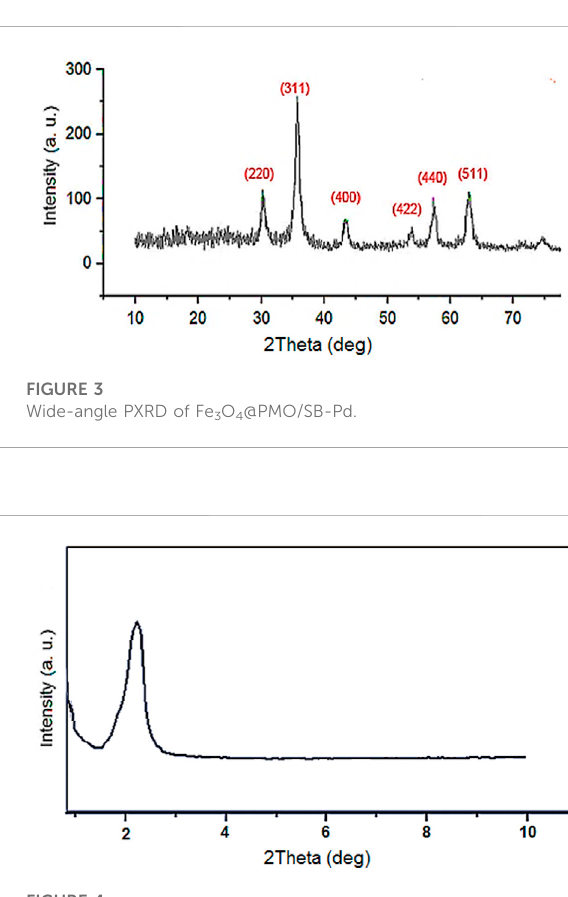
FIGURE 4 Low-angle PXRD of Fe 3 O 4 @PMO/SB-Pd.